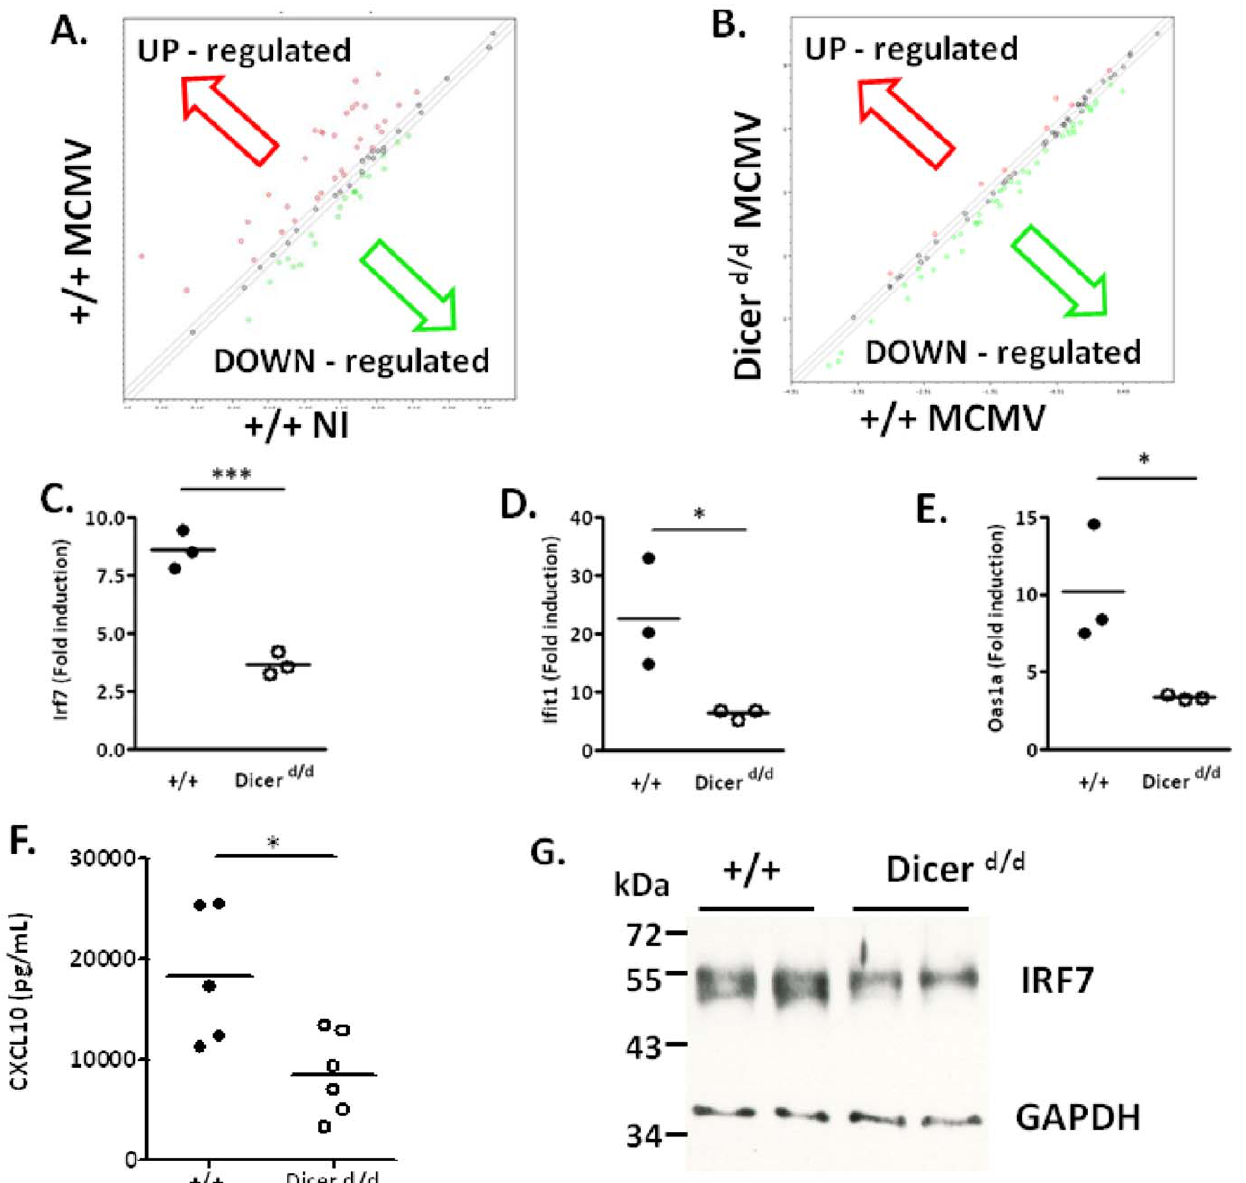
Figure 6. IFN-stimulated genes induction is impaired in MCMV-infected Dicer d/d mice. A. Scatterplot shows multiple IFN-dependent genes up-regulation (red dots) in MCMV-infected control mice ( + / + ). B. Scatterplot analysis comparing MCMV-infected controls ( + / + ) and Dicer d/d mice. C–E. qRT-PCR data on selected MCMV-inducible genes ( Irf7, Ifit1 and Oas1a ). The graphs show relative gene expression in controls (black spots; + / + ) and Dicer d/d (white spots) spleen extracts. F. CXCL10 was measured in the serum of controls (white dots, + / + ) and Dicer d/d mice (black dots) 36 hours p.i. G. IRF7 expression was analyzed by Western blot performed on protein extracts from MCMV-infected wild-type ( + / + ) and mutant mice. GAPDH expression serves a loading control.